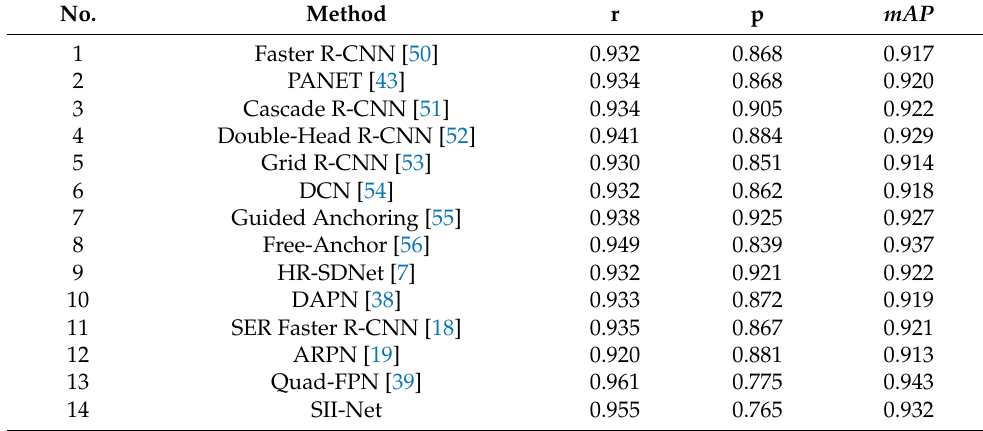
Table 7. Evaluation indices comparison with the other detectors on SAR-Ship-Dataset. No.